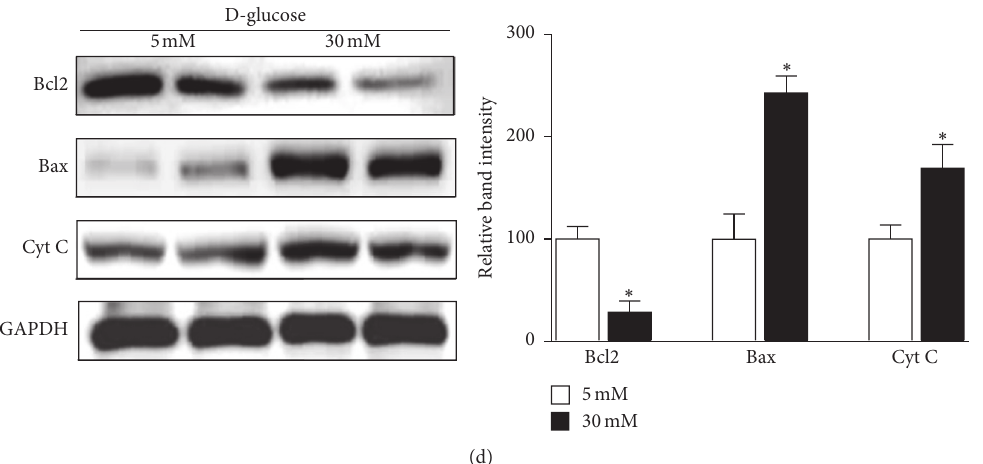
Figure 2: Effect of high-glucose (HG) conditions on mitochondrial dynamics, autophagy, apoptosis, and ROS production in human renal proximal tubular cells (RPTCs). (a, A, B, and C) Under high-glucose conditions, the number of MitoTracker Red-labeled mitochondria and the expression of LC3, an autophagy marker, decrease. (a, D and E) However, mitochondrial and cytosolic ROS increase, as detected by MitoSOX (red) or H2-DCFDA (green) staining. (b) Decreased mitochondrial mass, as assessed by the mtDNA/gDNA ratio, in human RPTCs under high-glucose condition. (c) Western blot analyses reveal upregulation of the mitochondrial profission protein Drp1; the profusion protein Mfn1 and the autophagy-related protein LC3II were downregulated. (d) Bax and cytochrome C, apoptosis regulatory proteins, were upregulated in a HG environment, whereas Bcl2, an antiapoptotic protein, was downregulated ( ∗ 𝑝 < 0.05 versus the 5mM glucose condition; scale bar 10 𝜇